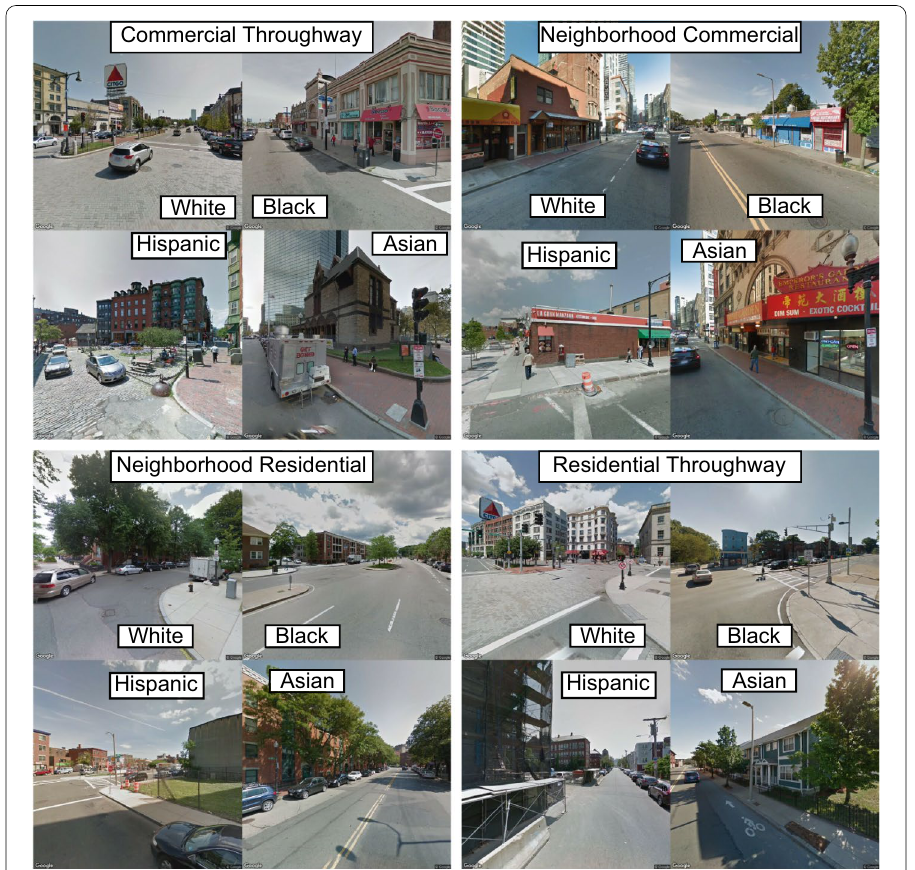
Fig. 5 Images exemplifying 4 street context for each